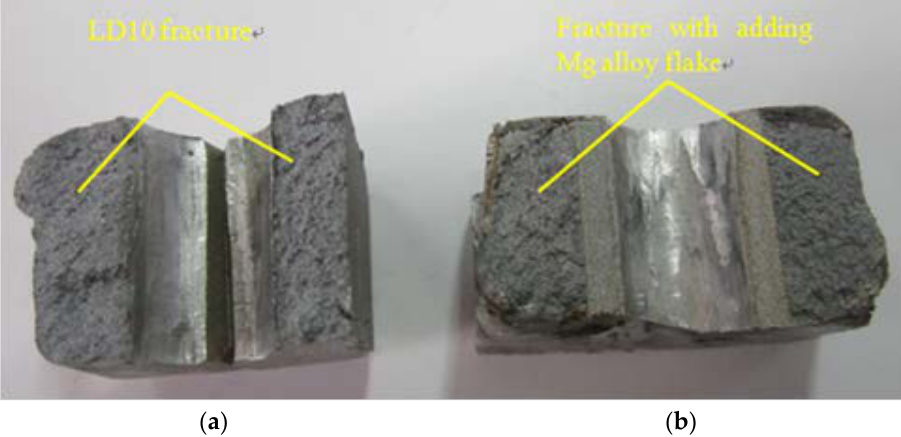
Figure 5. Macro fracture after casting cracking. ( a ) LD10 base material macro fracture, ( b ) foil added casting macro fracture.